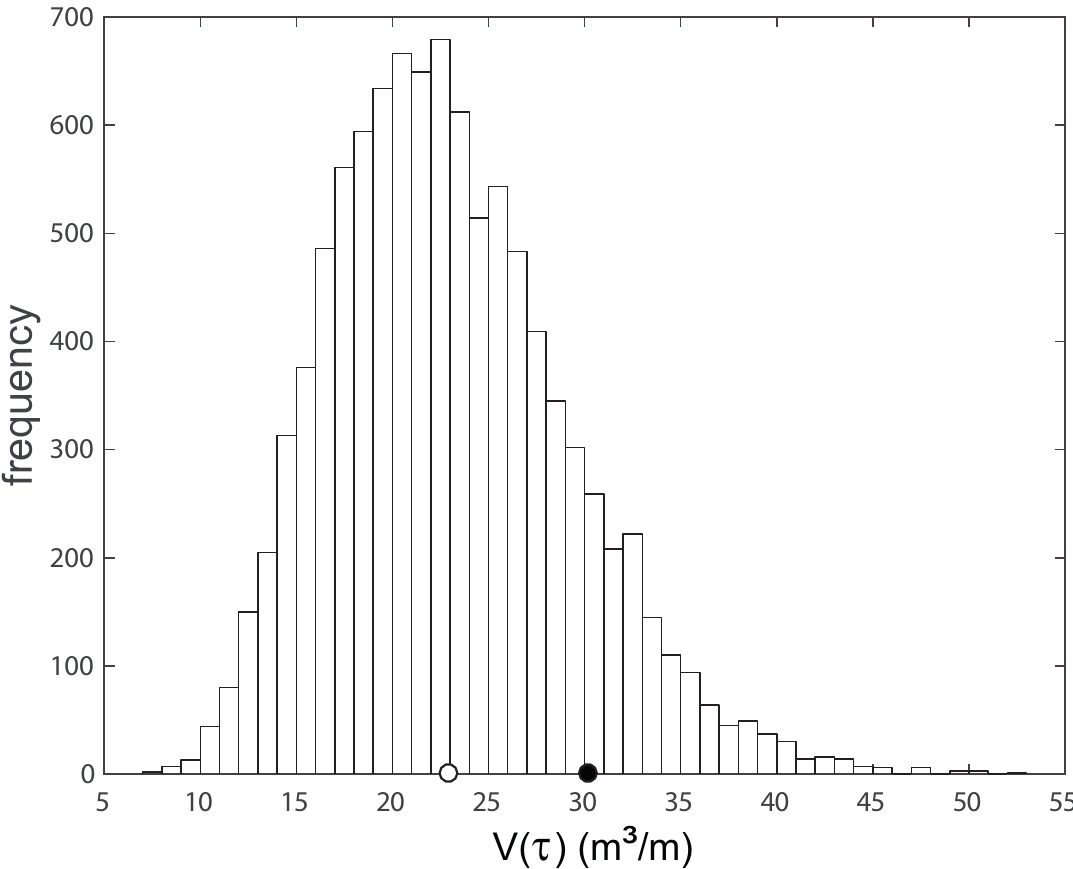
Figure 11. Distribution of the volume change built from a set of 10,000 simulations, based on the profiles at time instant t and t + τ , as given in Figure 10. The open disk is the mean simulated volume change and the black disk is the observed volume change between time instants t and t + τ